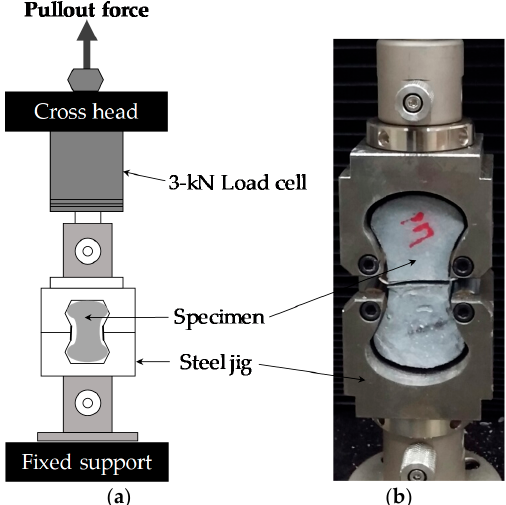
Figure 2. ( a ) Schematic of steel fiber static pullout behavior test setup, ( b ) grip details.